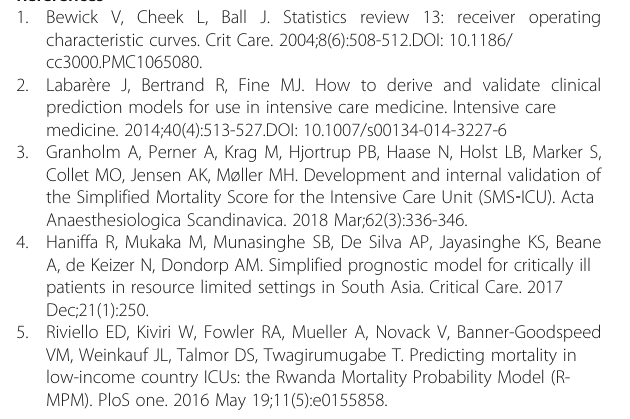
Fig. 3 (abstract P5). The area under the receiver operating characteristic (ROC) curve for mortality prediction of each model of simplified THAI-ICU scores, comparing with APACHE II and SOFA in validation cohort. AUC; area under ROC curve